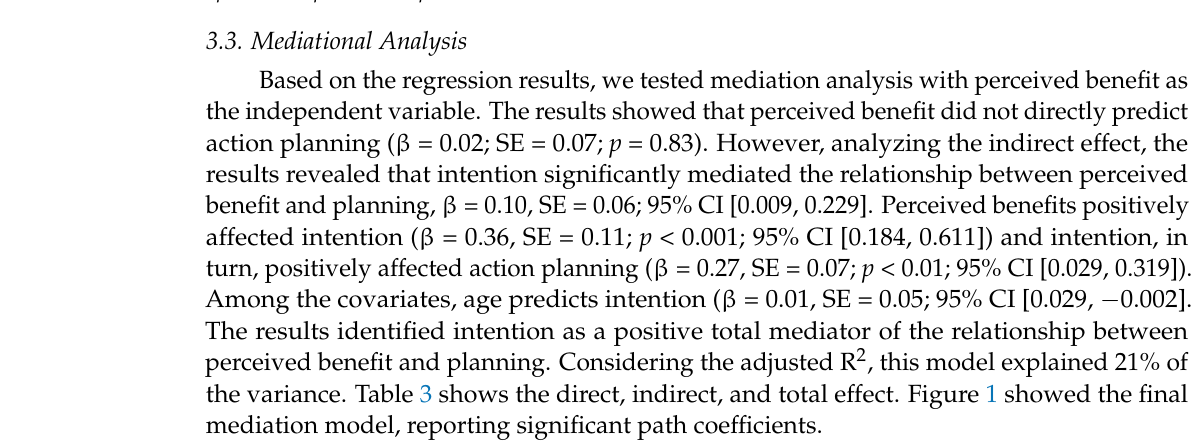
Table 3. Mediation